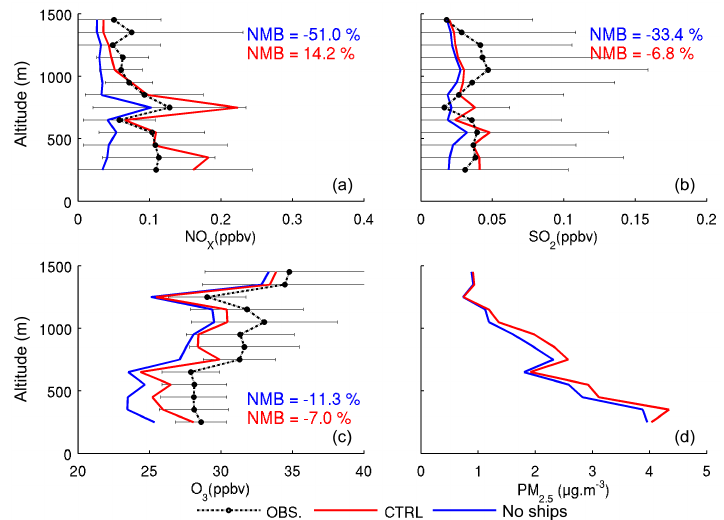
Figure 8. Average vertical profiles of (a) NO x , (b) SO 2 , (c) O 3 and (d) PM 2 . 5 observed during the four ACCESS ship flights (in black, with error bars showing standard deviations), and interpolated along the ACCESS flight tracks in the CTRL simulation (red line) and in the NOSHIPS simulation (blue line). For PM 2 . 5 only simulation results are